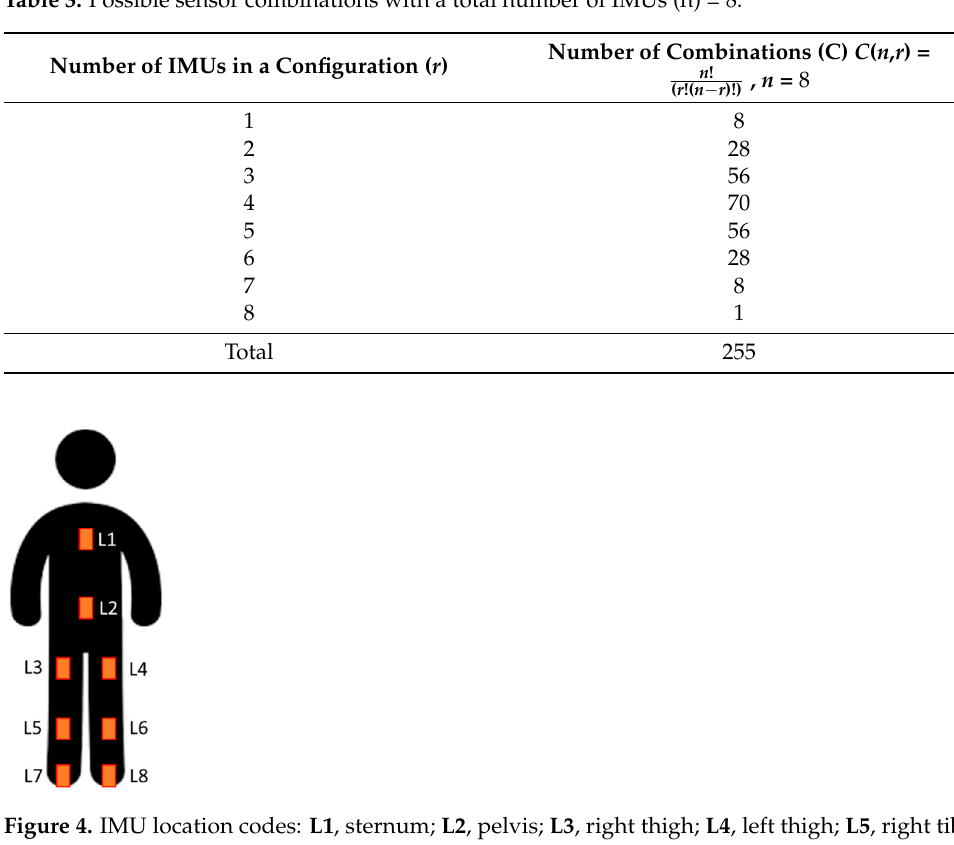
Table 3. Possible sensor combinations with a total number of IMUs (n) = 8.